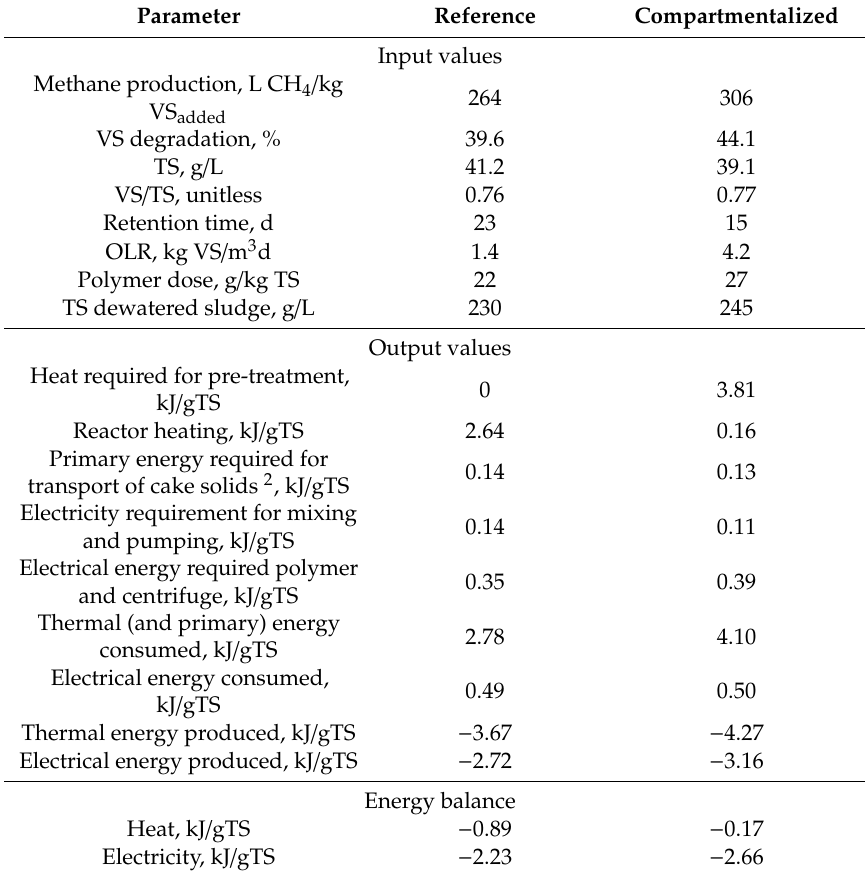
Table 4. Energy balance 1